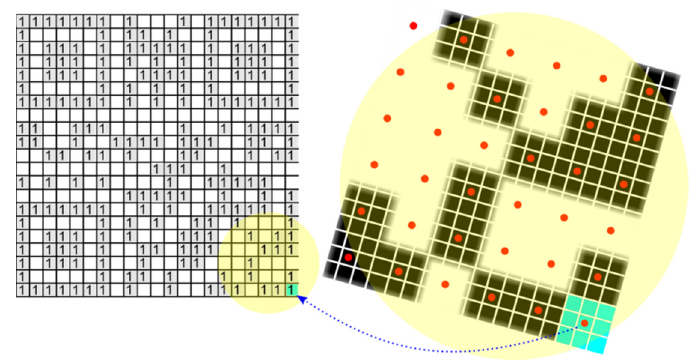
Figure 18. Mapping of the QR Code into the binary matrix.